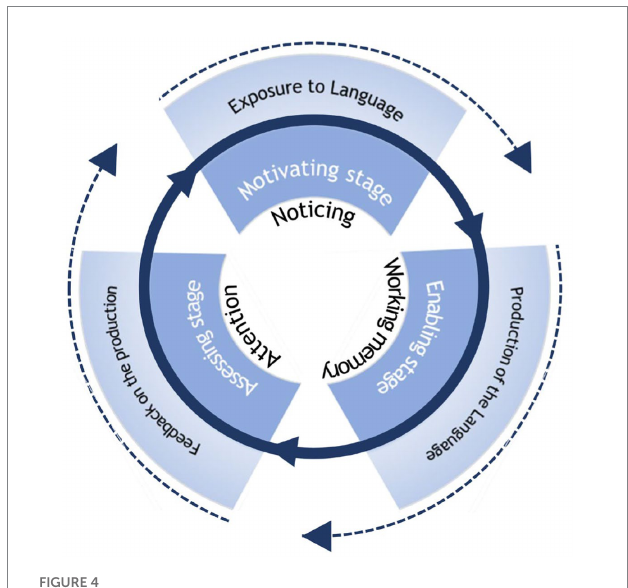
FIGURE 4 Interaction-based POA